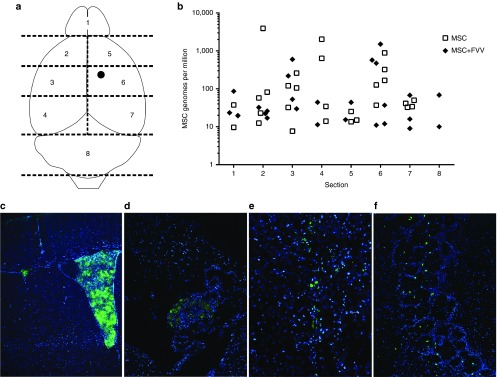
Foamy virus vector (FVV)-transduced mMSCs maintain their ability to graft in the brains of mice following intracerebroventricular delivery. (a) Sectioning of female mouse brains for qPCR analysis to determine long-term engraftment and distribution of male mMSCs 3 months after the direct delivery of 80,000 mMSCs into the right lateral ventricle (approximate location indicated with solid black circle). The dashed lines indicate the cuts made to produce eight sections (numbered). (b) qPCR analysis to quantify mMSCs in the brain sections depicted in a. Each data point represents a section from one mouse. White squares show the engraftment of untransduced mMSCs, whereas black diamonds show the engraftment of FVV transduced MSCs. Data for each group is from six treated mice. Only sections that were above the detection limit are shown. (c–f) Photomicrographs showing direct GFP fluorescence in mouse brains following injection of mMSCs transduced by FVV:PGK-GFP. Nuclei, stained with DAPI, are shown in blue. (c) Right lateral ventricle immediately postinjection; (d) Choroid plexus 45-days postinjection; (e) parenchyma showing needle track, 45-days postinjection; (f) glomerular layer of olfactory bulb, 45-days postinjection.